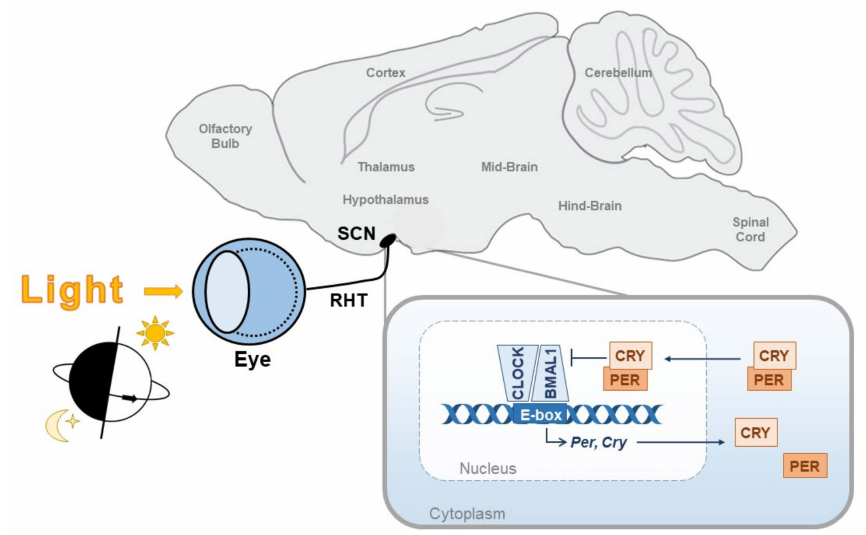
Figure 1. The circadian clock. The core circadian clock consists of a molecular transcriptional- translational feedback loop in which the transcription factors, CLOCK and BMAL1, heterodimerise and induce expression of the core clock genes, Per and Cry , via E-box response elements. PER and CRY then feedback onto CLOCK and BMAL1 by inhibiting their transcriptional activity. This feedback loop cycles with a period of around 24 h, therefore it must be continually readjusted to be aligned with the external world. The primary time cue for this is the daily light/dark cycle. Light information is transmitted via the retinohypothalamic tract (RHT) directly to the master clock in the suprachiasmatic nucleus